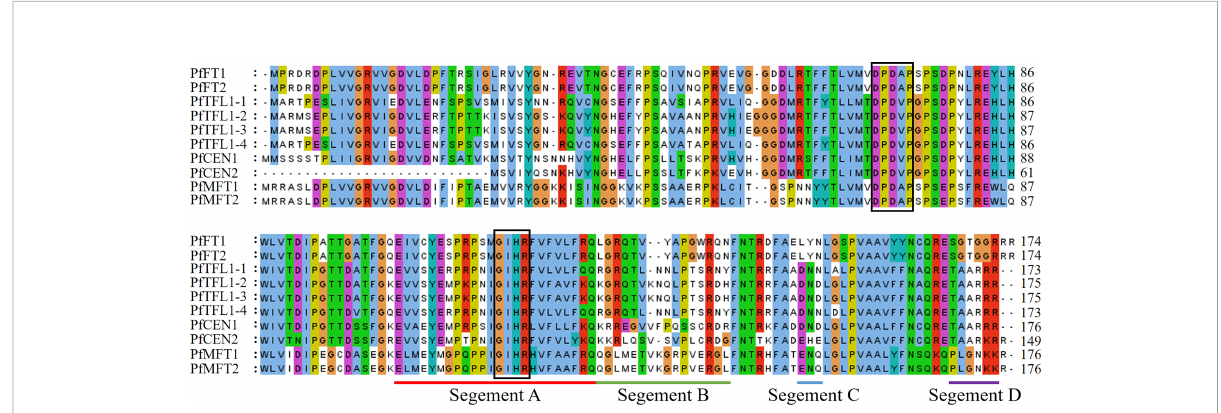
FIGURE 2 Multiple sequence alignment of PEBP in P. frutescens . Conserved motif DPDxP and GIHR was marked with black frame, respectively. Segment A – D was underlined with different colors.